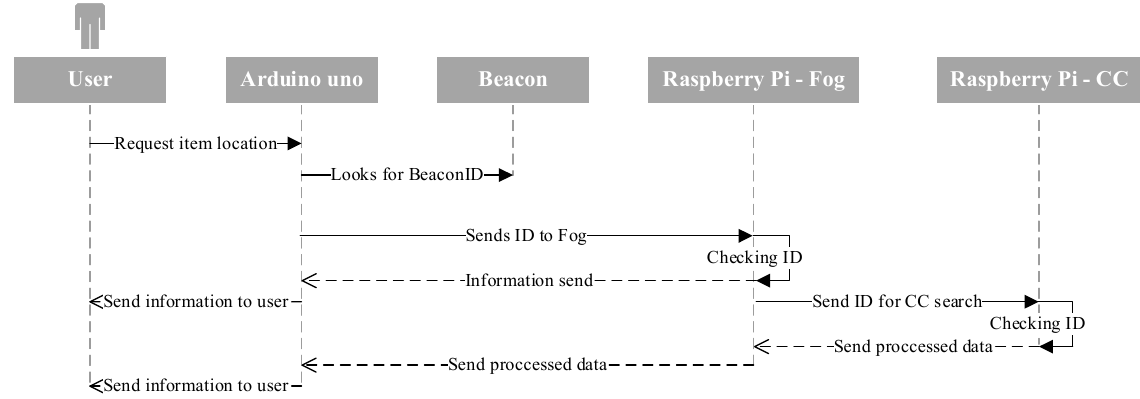
Figure 5. Information flow of simulation